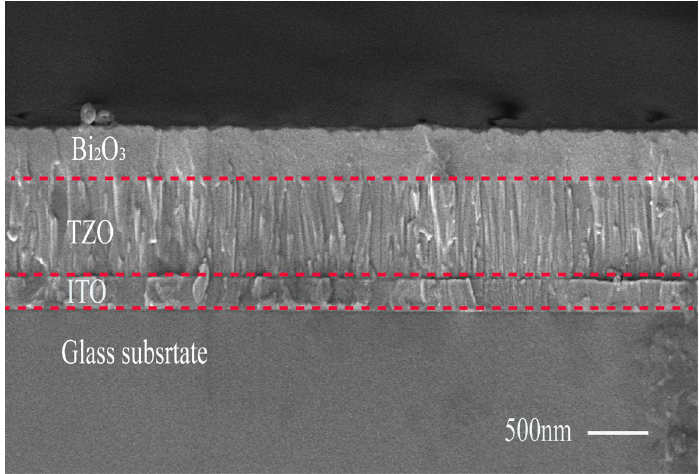
Figure 3. A cross-sectional SEM image of TZO/Bi 2 O 3 thin film heterojunction.